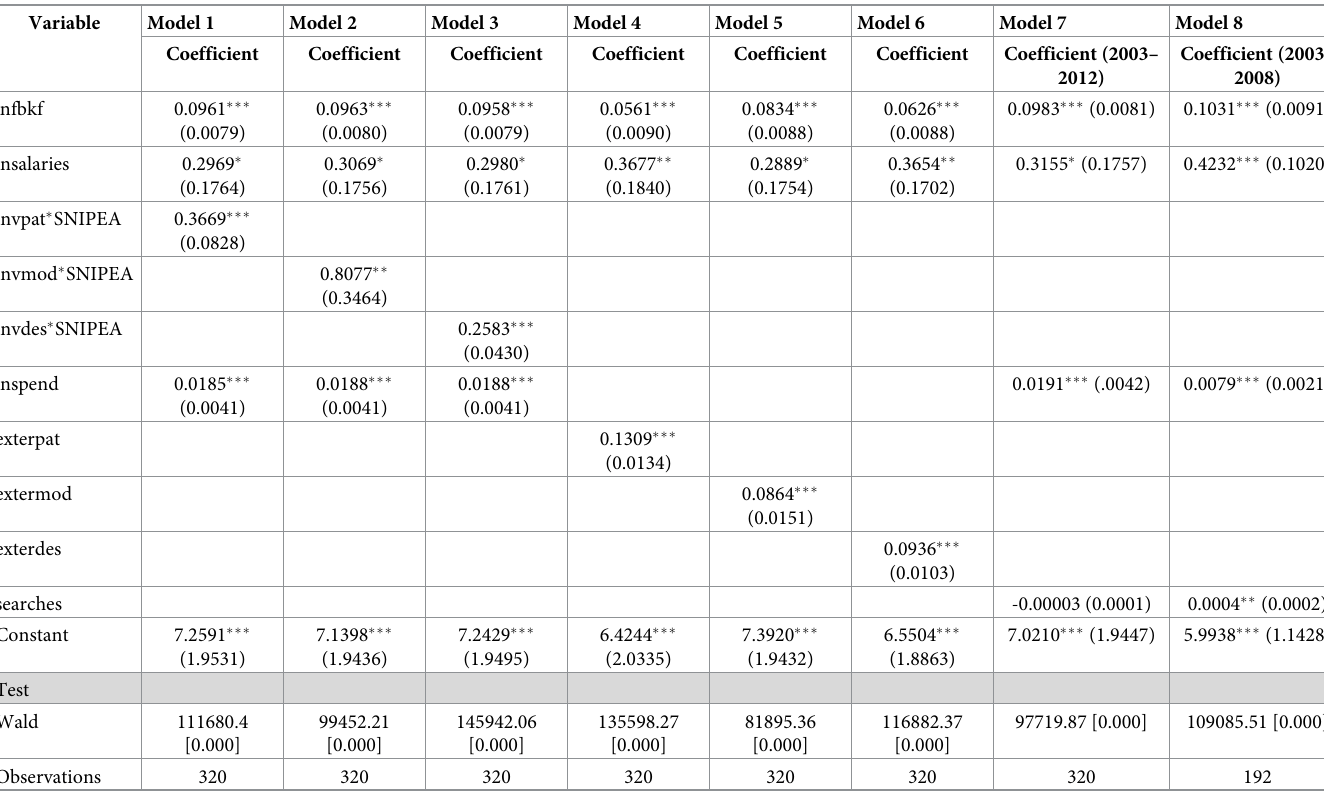
Table 5. Fixed effects estimates with PCSE heteroskedasticity correction.